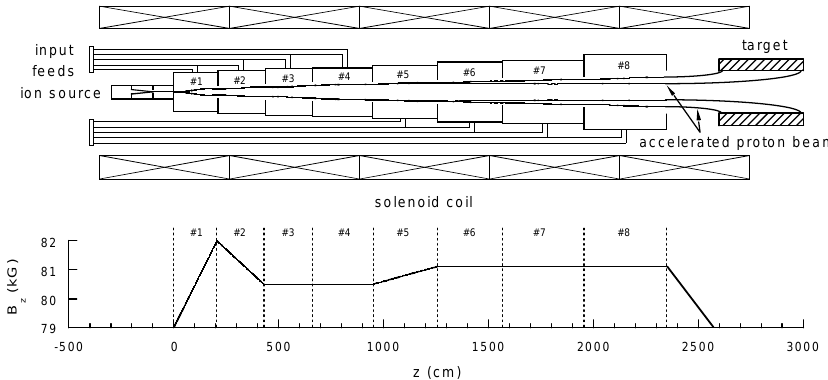
FIG. 1. Schematic of the multicavity proton cyclotron